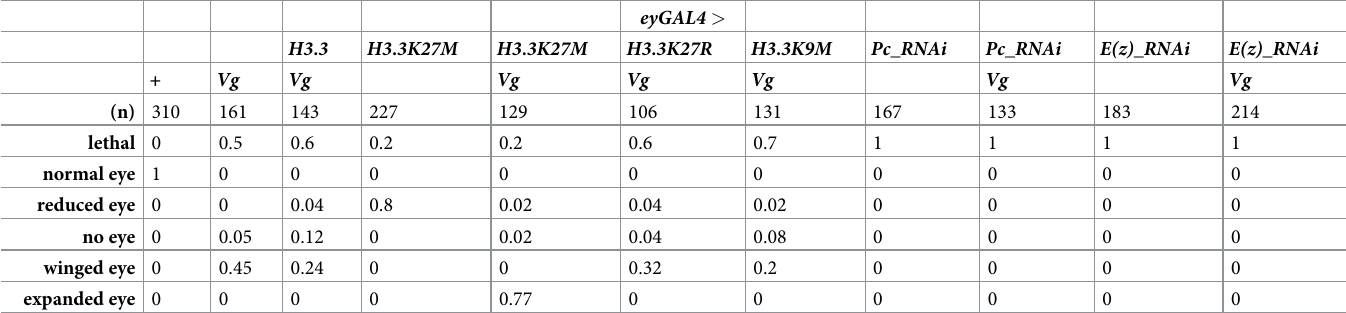
Table 1. Effect of Vg, H3.3 mutations, and RNAi knockdown on eye-to-wing reprogramming.